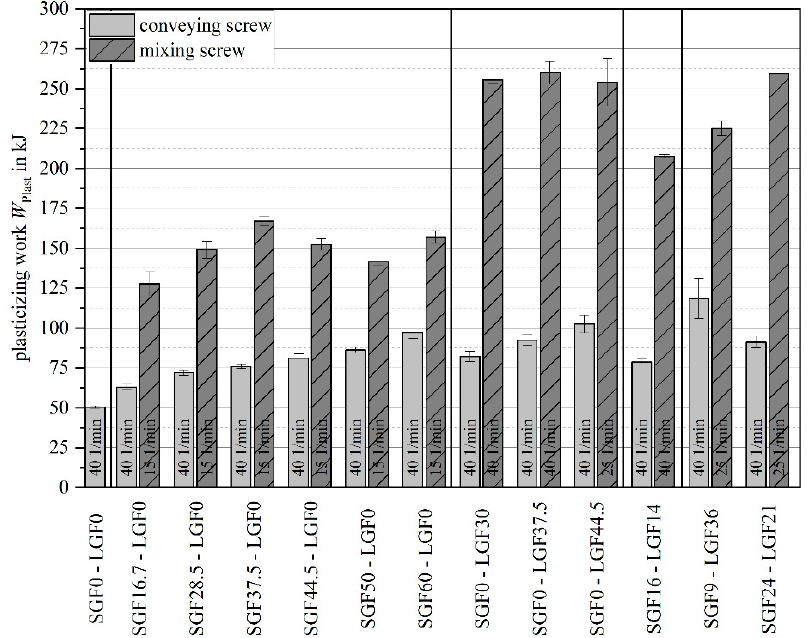
Figure 10. Plasticizing work for screw layout and material